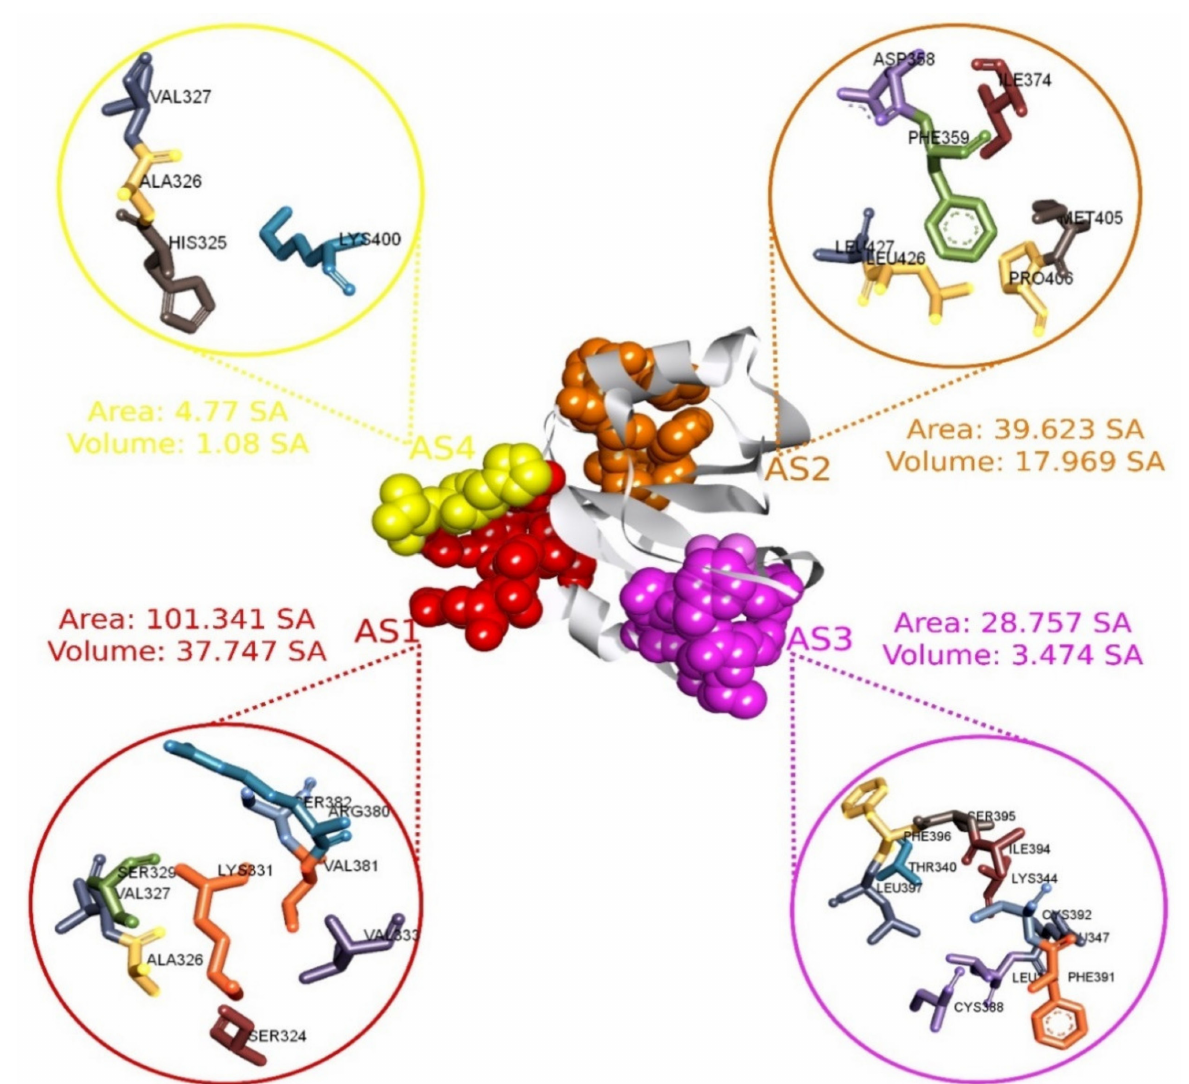
Figure 2. The four selected active pockets of MCPyV LT (PDB: 3QFQ) with the surface area calculated by the CASTp server, adapted from ref. [14]. The first active site (AS1) and its corresponding aa are represented in red, AS2 in orange, AS3 in purple, and AS4 in